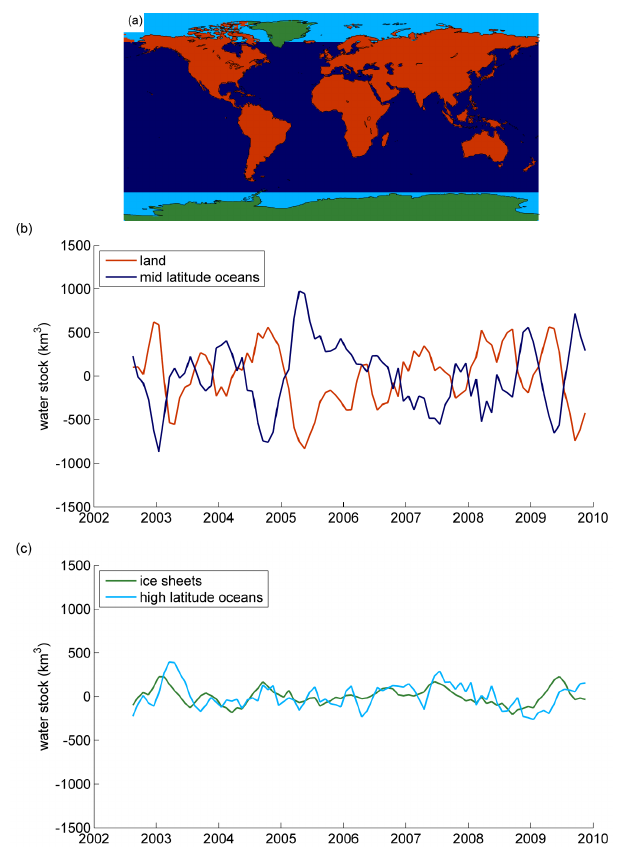
Figure 2: (a) Land and ocean masks (high latitude Arctic and Antarctic oceans in light blue and ice sheets in green). (b) Detrended interannual variations of GRACE derived water stocks in land (except ice sheets) and oceans (except high latitudes). (c) Detrended interannual variations of GRACE derived water stocks in ice sheets and high latitude oceans.